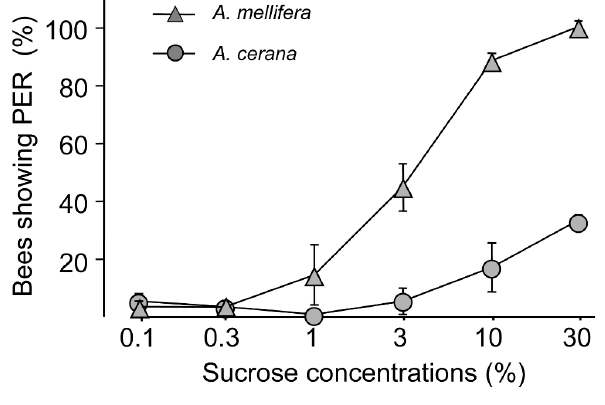
Figure 3. Percentage of bees showing proboscis extension response (mean+SE) of 14-day-old workers from three mixed-species colonies, of Apis mellifera (triangles) and A. cerana (circles). %PER were significantly higher in A. mellifera than A. cerana . Data based on 3 mixed-species colonies (N = 60 bees).